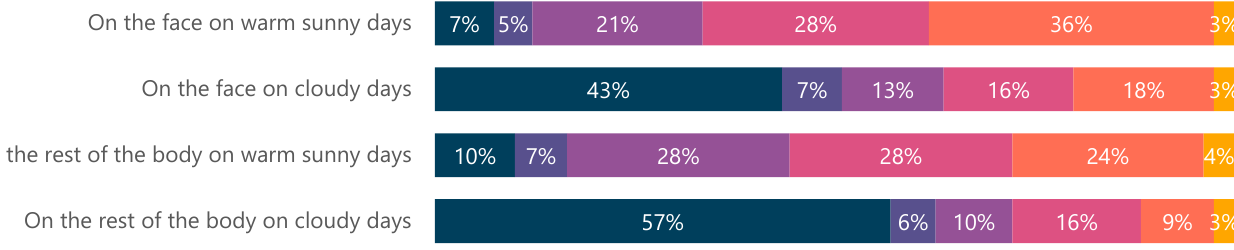
Figure 2. SPF used in various circumstances.